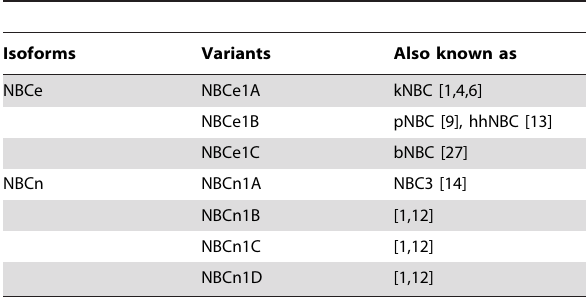
Table 1. Splice variants of NBCe and NBCn isoforms and their alternative